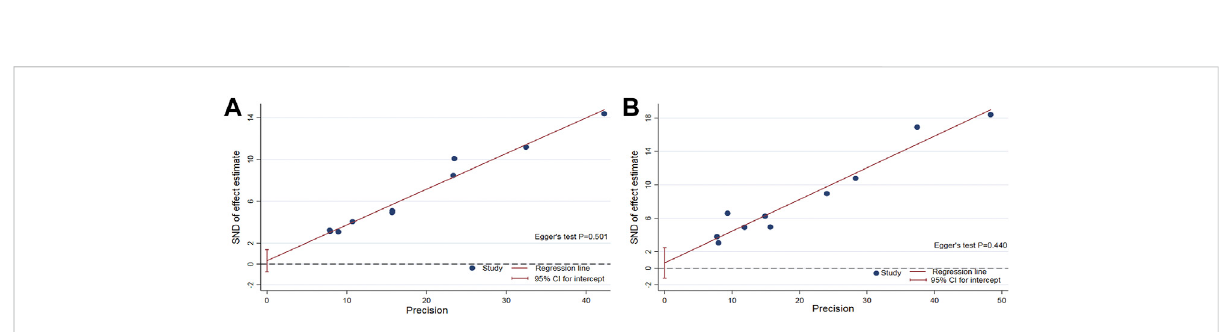
FIGURE 5 Egger ’ s test to measure the funnel plot asymmetry of the pooled percentage of improved PC (A) and the pooled percentage of improved PD bother score (B) .